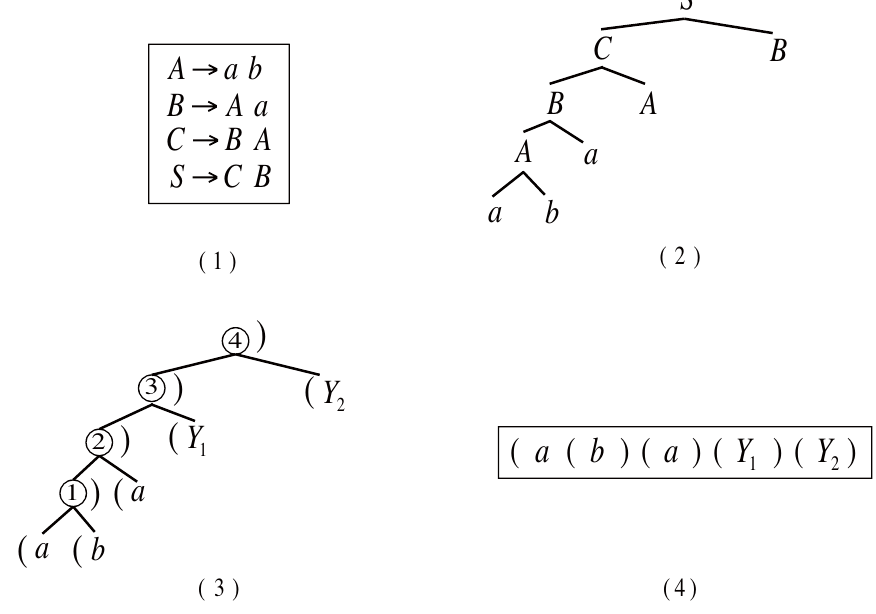
Figure 5. The example of the encoding process for CFG G = ( { a, b } , { A, B, C, S } , D , S ) : ( 1 ) the dictionary D ; ( 2 ) the partial parse tree P T ree ( G ) ; ( 3 ) the parentheses representation = i + σ ; and ( 4 ) the encoded representation of G of the tree and renamed labels where Y i